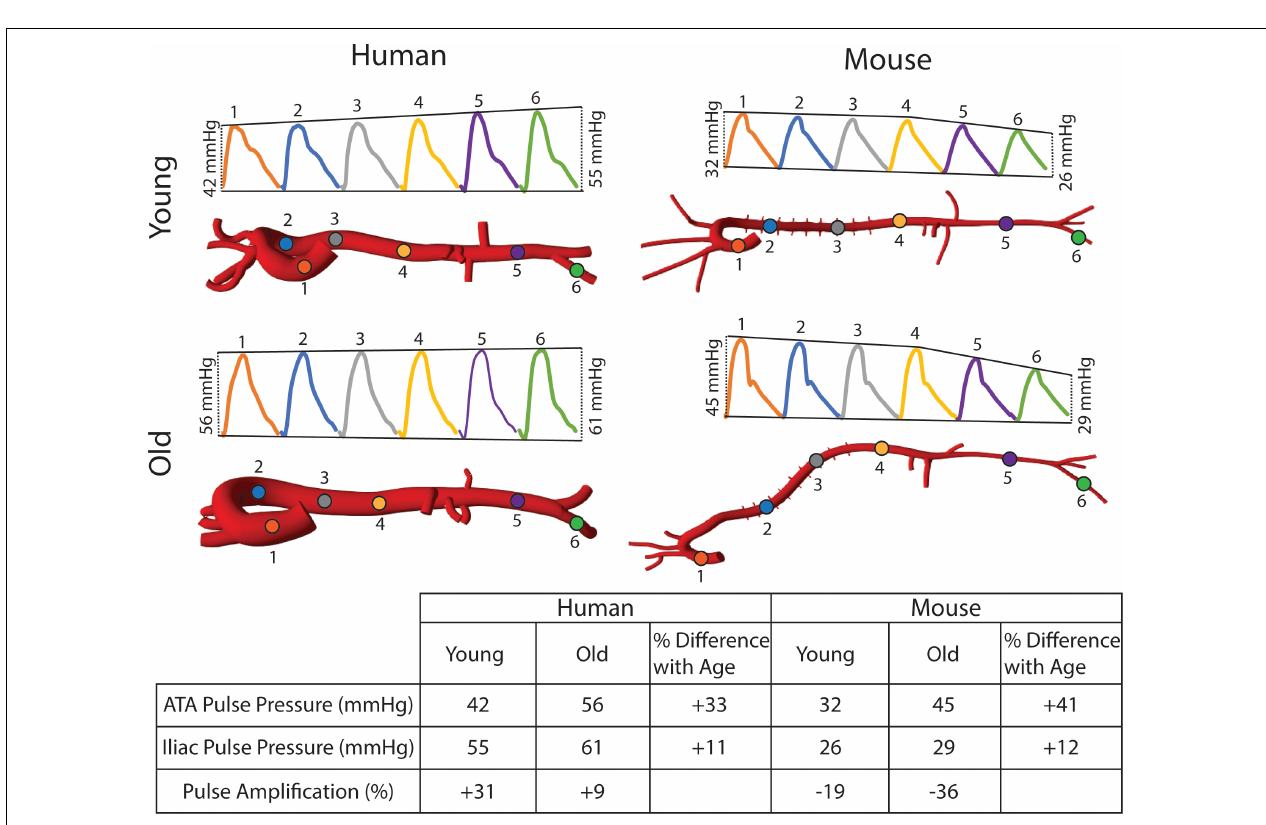
FIGURE 8 | Computed values of mean arterial pressure (MAP) for five aortic locations (ATA, ascending thoracic aorta; pDTA, proximal descending thoracic aorta; dDTA, distal descending thoracic aorta; SAA, suprarenal abdominal aorta; and IAA, infrarenal abdominal aorta) and an iliac artery for all four primary study groups, all showing modest changes proximal to distal.